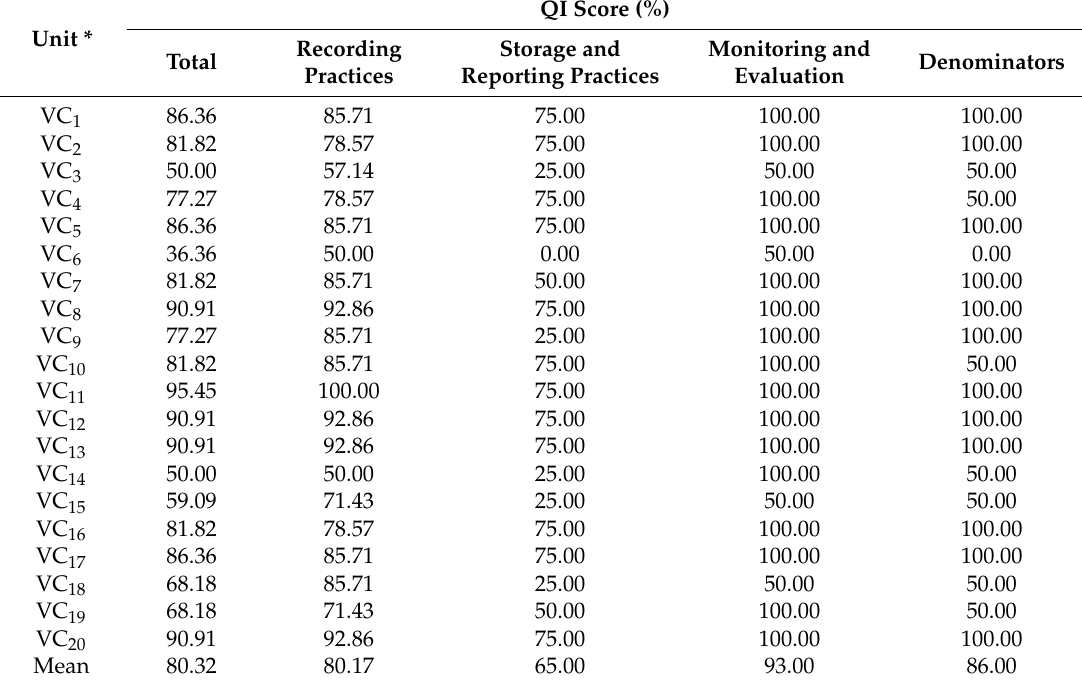
Table 2. QI (quality index) scores by vaccination clinics and components from the data quality audit (DQA) in Shangyu District, 2014. QI Score (%) Unit * Recording Storage and Monitoring and Total Practices Reporting Practices Evaluation